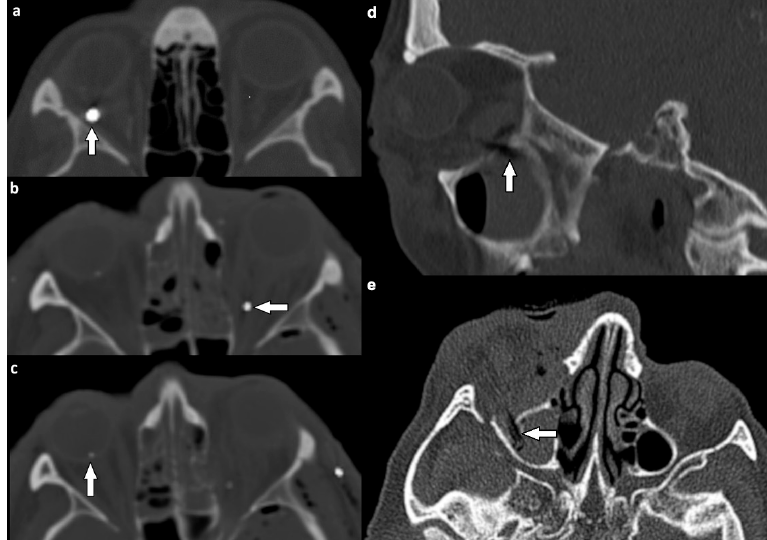
Figure 7. Intraorbital foreign bodies. NE-MSCT, bone window, axial reformation. ( a ) Metallic foreign body (white arrow) within the right lateral rectus muscle. ( b , c ) Multiple metallic foreign bodies in one patient ( b ) near the left optic nerve (white arrow) and ( c ) within the rear wall of the ocular globe (white arrow). ( d , e ) Wooden foreign body in the right orbit (white arrows) piercing through the orbital floor into the right maxillary sinus. Concomitant hematosinus and pronounced proptosis due to retrobulbar hematoma and swelling. Hypodense air bubbles entrapped within the otherwise undetectable dry wood. NE-MSCT, bone window and bone kernel in ( d ) sagittal and, ( e ) axial reformation (NE-MSCT = non-contrast-enhanced multi-slice CT).